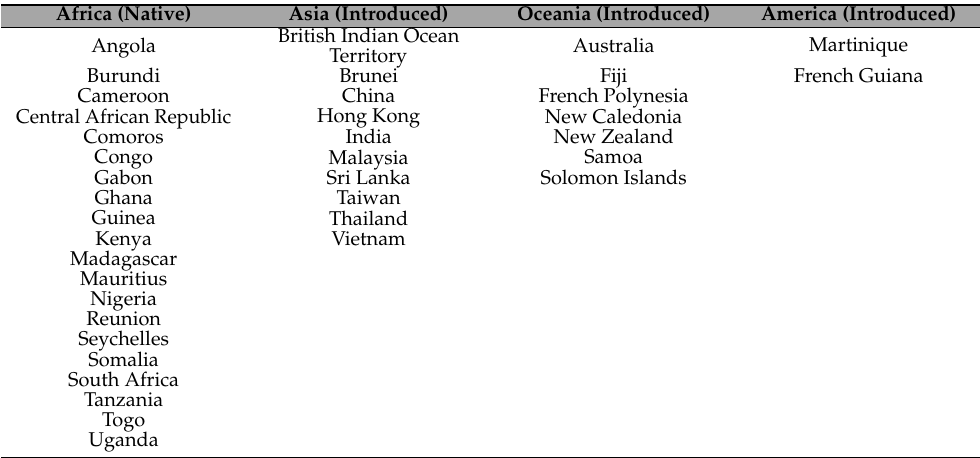
Figure 3. Recorded global occurrence of Navua sedge ( Cyperus aromaticus ) . Data of the species global occurrence were obtained from the Global Biodiversity Information Facility (2021) with a total of 427 records. Areas within the green closed circles are considered within its native range while those within the closed red circles are considered within its introduced range. Table 1. The countries within Africa where Navua sedge is thought to be native and the countries in Asia, Oceania and America where Navua sedge has been introduced.